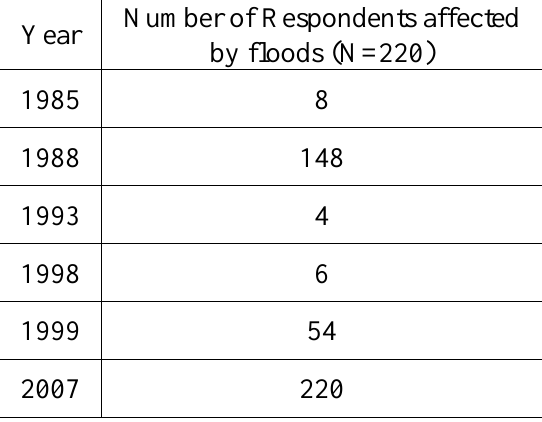
Table 1. Occurrence of floods in the study